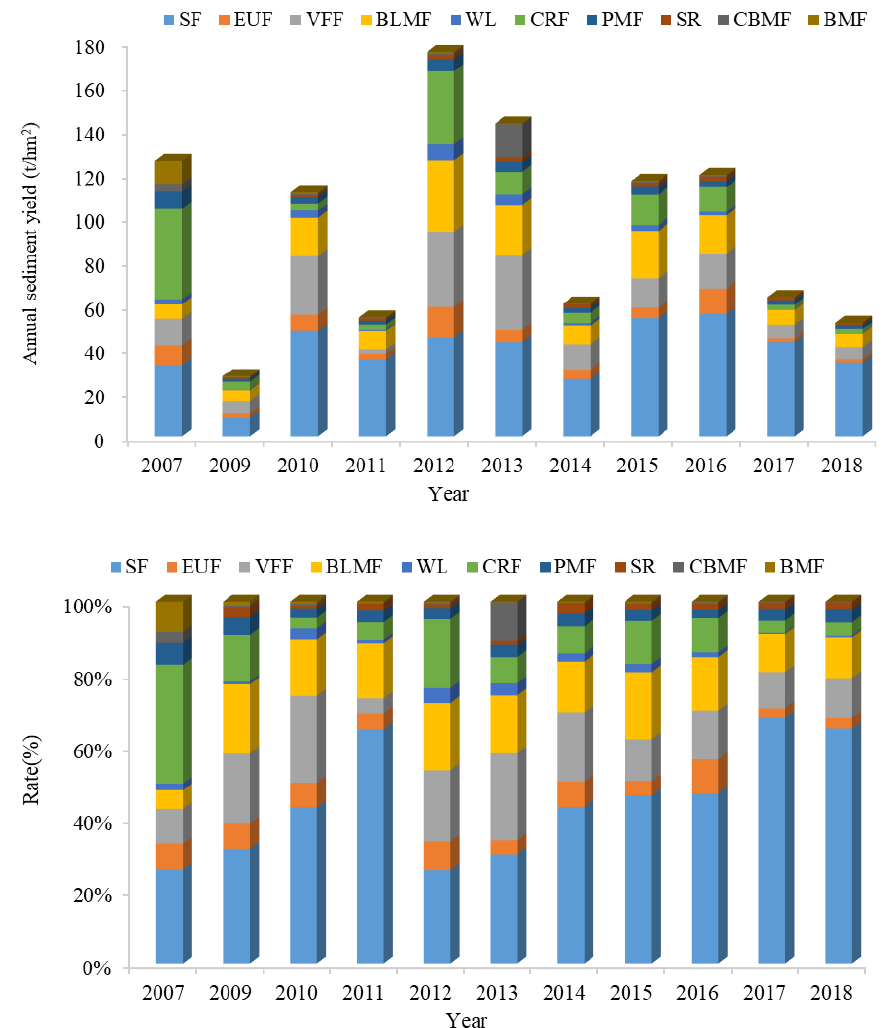
Figure 9. Annual sediment yield for each vegetation type between 2007 and 2018.